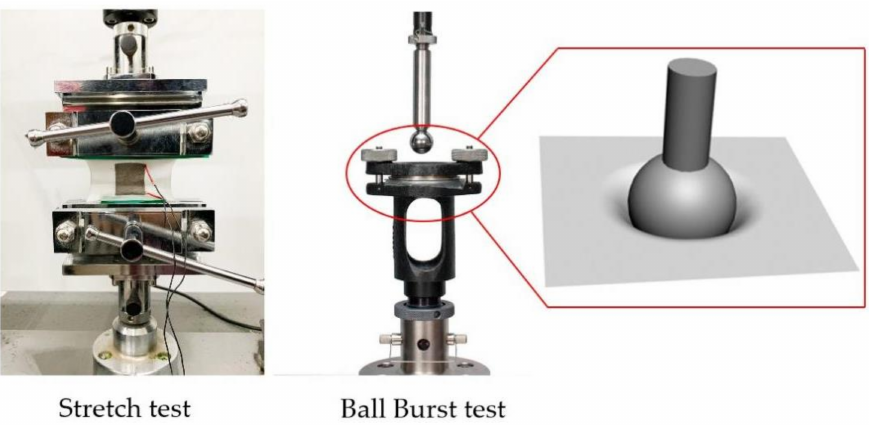
Figure 2. Experimental